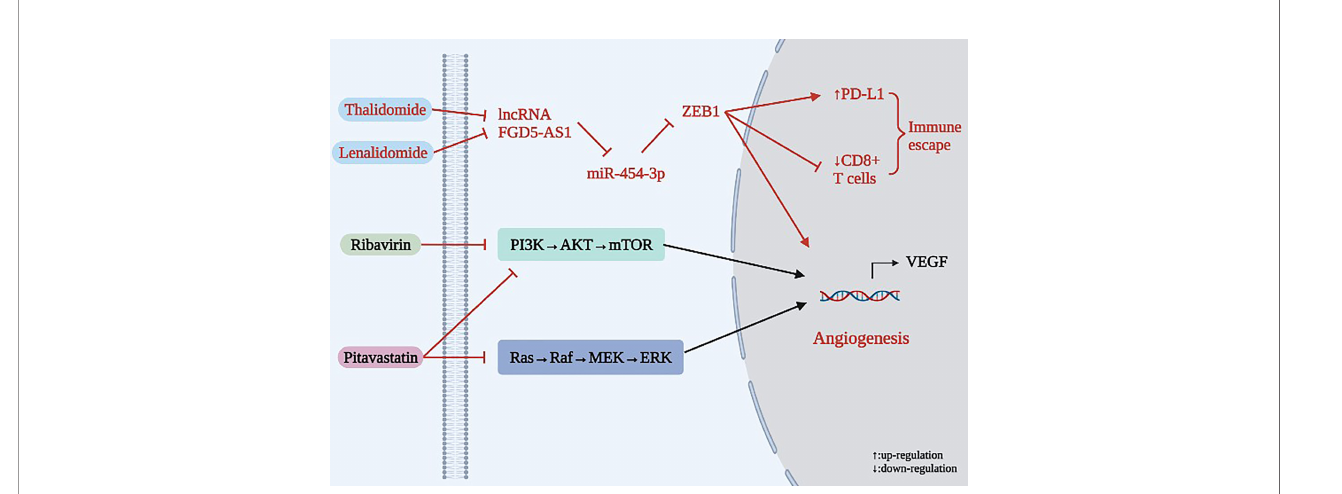
FIGURE 6 | Mechanism of anti-angiogenesis for existing chemical medicine in lung